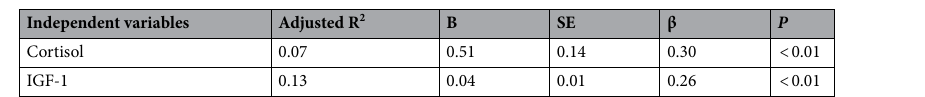
Table 2. Stepwise multiple regression analysis of the relationship between the Hamilton Rating Scale for Depression scores and independent variables. IGF-1 insulin-like growth factor 1, B non-standardized regression coefficient B, SE standard error, β standardized regression coefficient beta.